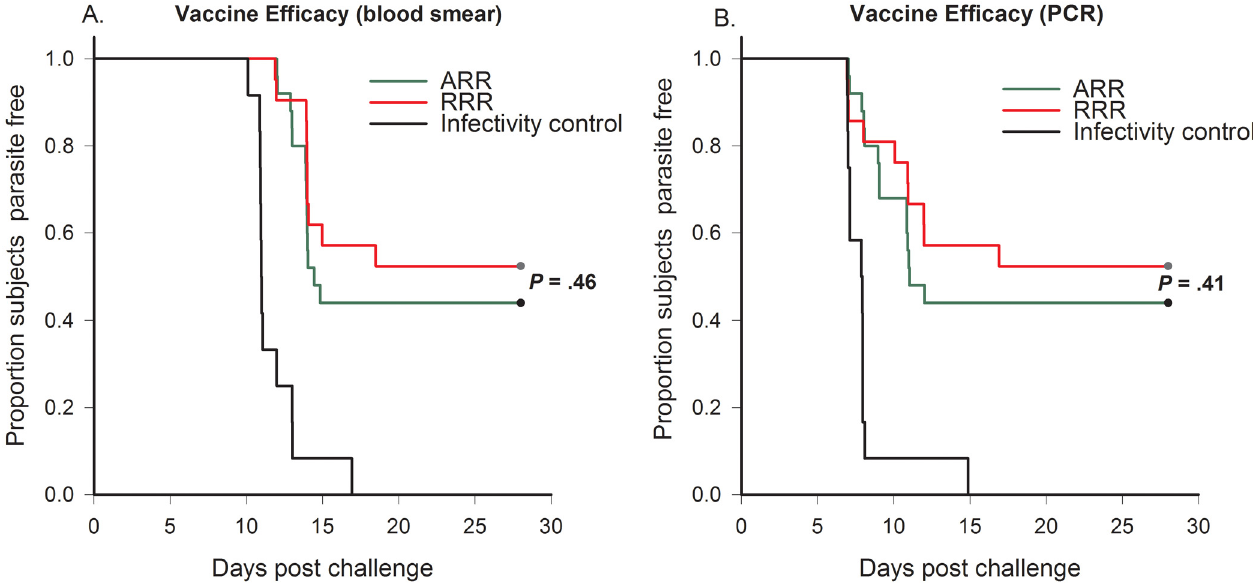
Fig 2. Kaplan-Meier curves for time to parasitemia by blood smear (A) and PCR (B) for ARR (green), RRR (red), infectivity control (black) subjects (ATP efficacy). Log-rank analysis showed statistically significant differences between ARR and control subjects (P < .0001) and RRR and control subjects (P <